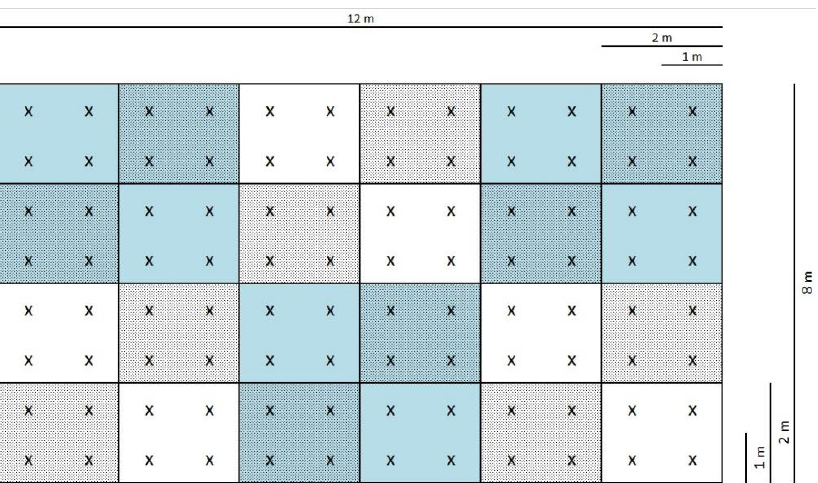
Figure 1. Split-split plot experimental design nested by year for testing the effect of leaf litter mulch on the presence of predatory nematodes (Gödöllő, Hungary, 2016–2019). Coloration means irrigated vs. non-irrigated treatment (blue vs. white); dotted means mulched vs. unmulched treatment (dotted vs. undotted), “X” shows tomato plants.